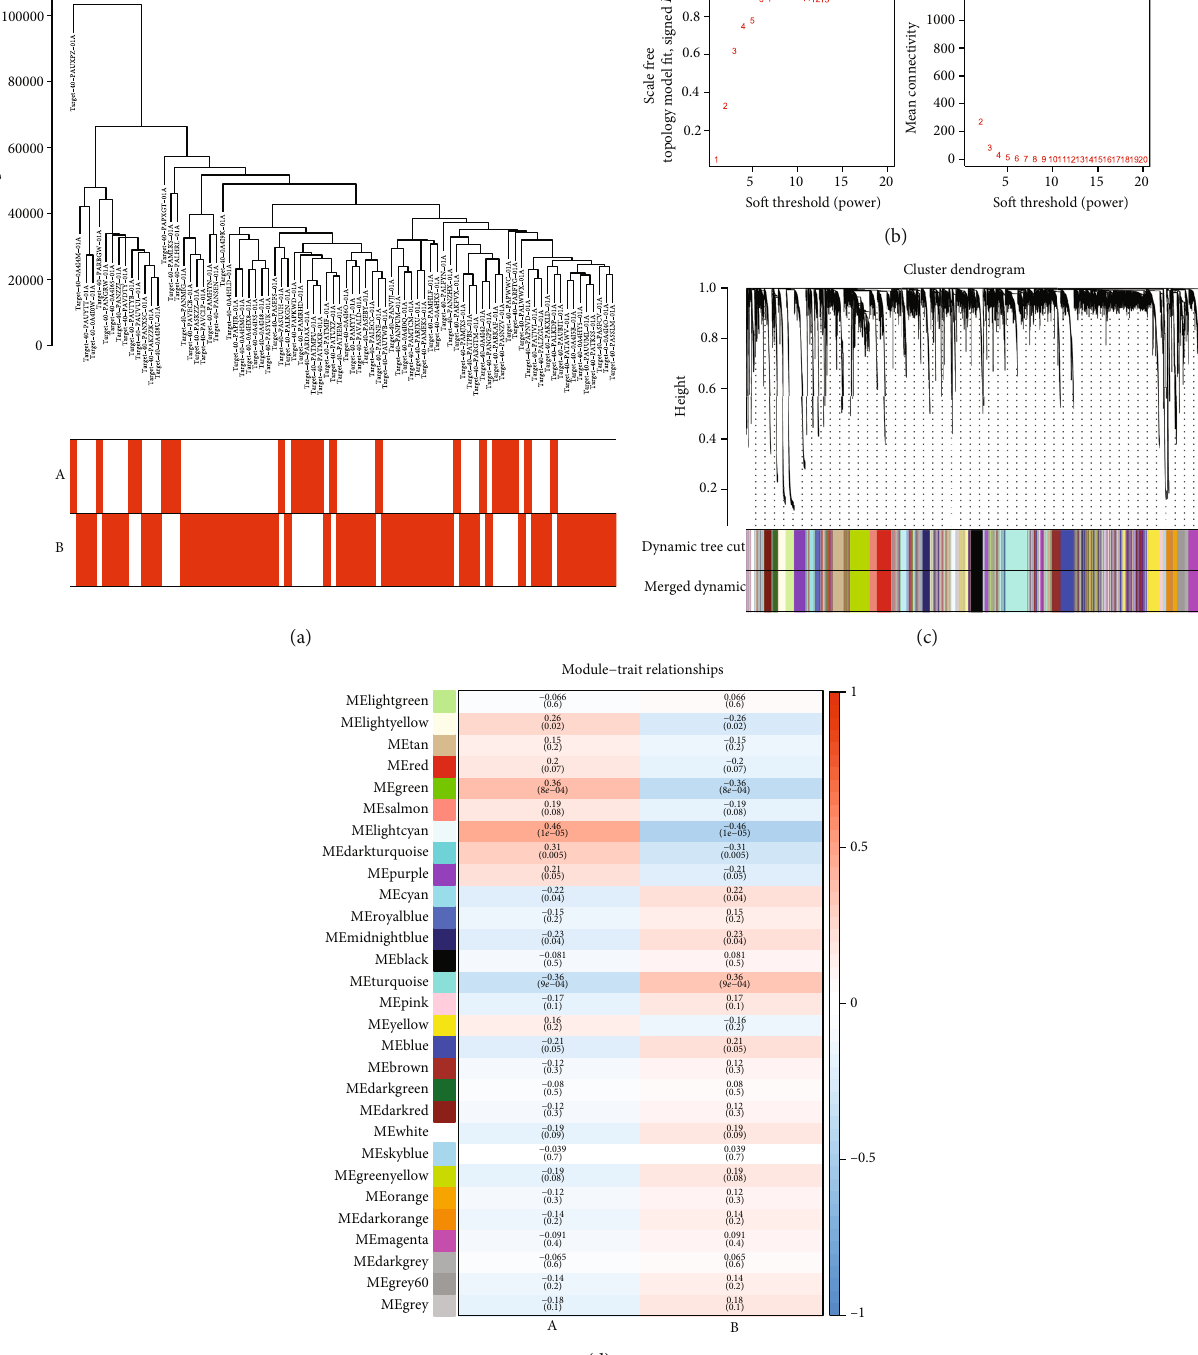
Figure 4: Establishment of EMT subtype-relevant coexpression modules in the TARGET cohort. (a) Hierarchical clustering dendrogram of osteosarcoma individuals as well as the matched EMT molecular subtypes. (b) Analyses of network topology and average network connectivity under diverse soft-threshold powers ( β ). The red line is indicative of a correlation coe ffi cient of 0.85. (c) Clustering dendrogram with dissimilarity in accordance with topological overlapping, along with designed module colors. (d) The interaction network between modules and EMT molecular subtypes. Each column is indicative of EMT molecular subtype while each row is indicative of a coexpression module. The number in the rectangle displays the correlation coe ffi cient and P